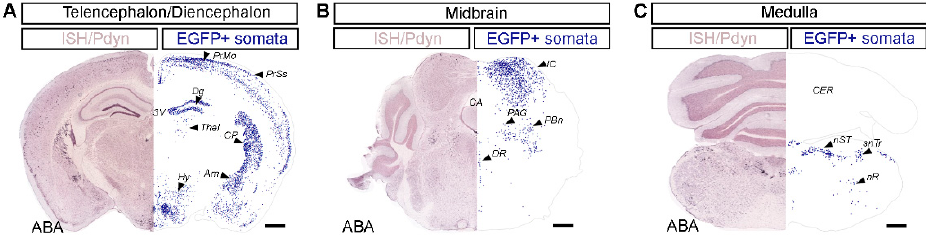
Figure 1. Immunohistochemical mapping revealed that regional distribution of dynorphinergic neurons in the brain of a Pdyn::cas9-EGFP mouse shows large similarity to the reference atlas provided by the Allen Institute. The distribution of Pdyn neurons was evaluated by plotting